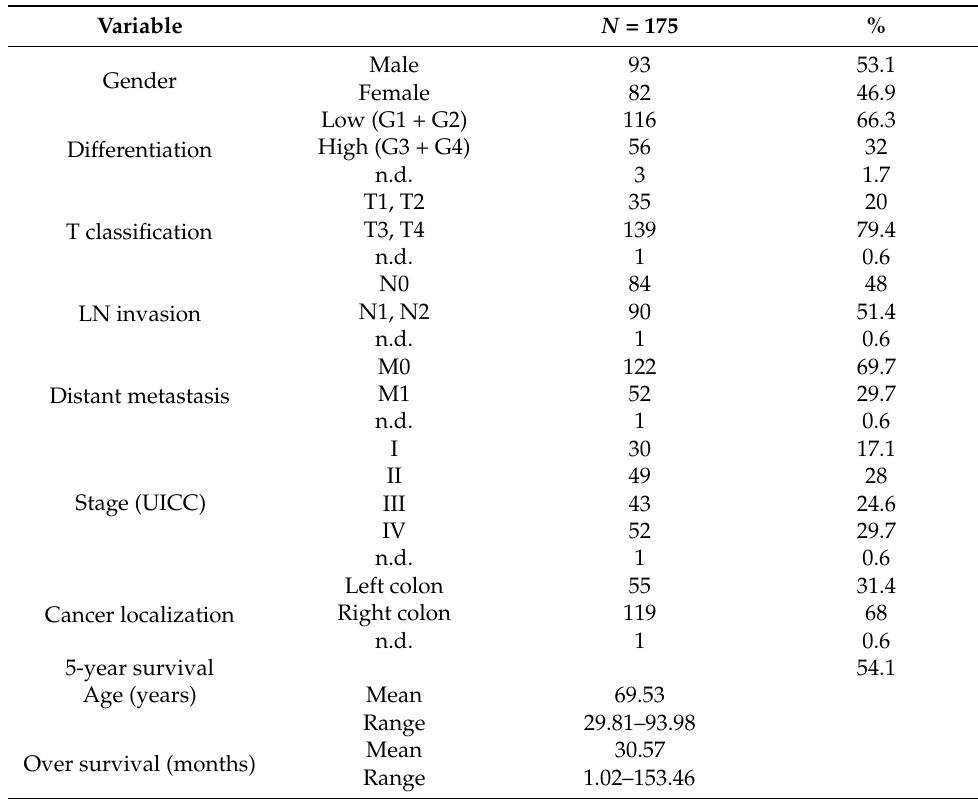
Table 1. CRC patients’